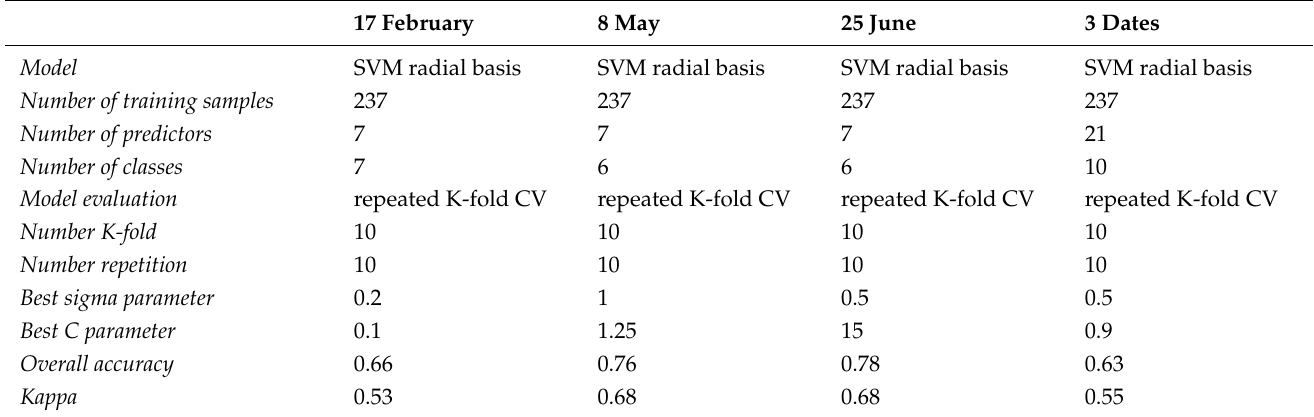
Table 1. Summary of the parameters and evaluation of the classification